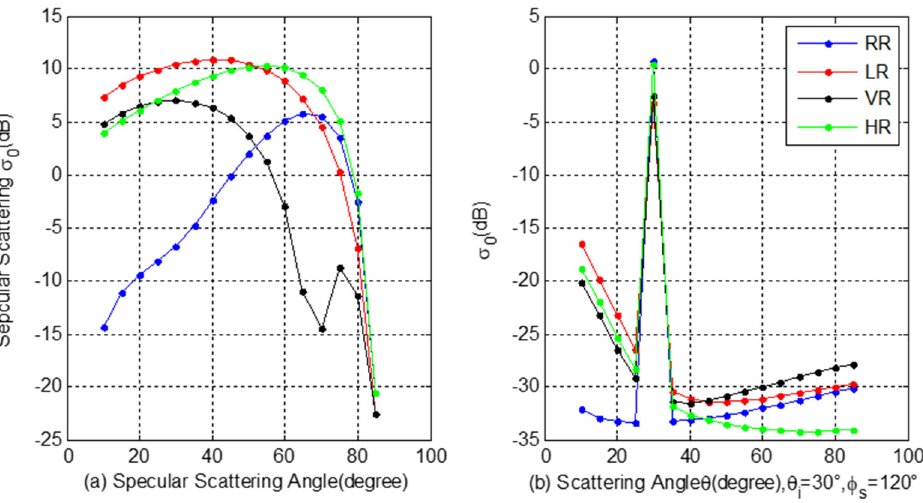
Figure 3. Specular ( a ) and non-specular ( b ) scattering characteristics of various polarizations.